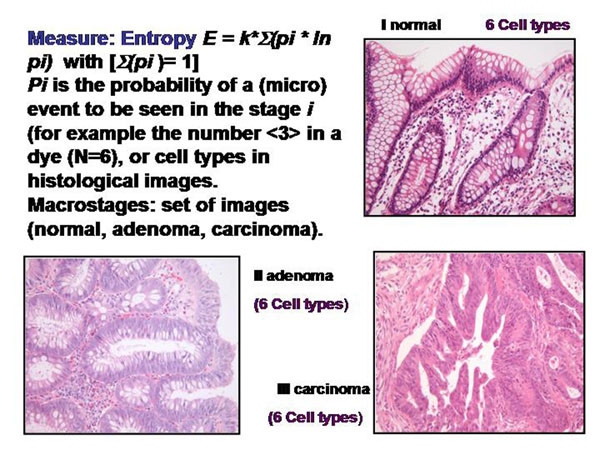
Example of cell types in histological images of colon diseases (normal, adenoma, and carcinoma) used for entropy calculation (Shannon and Tsallis)